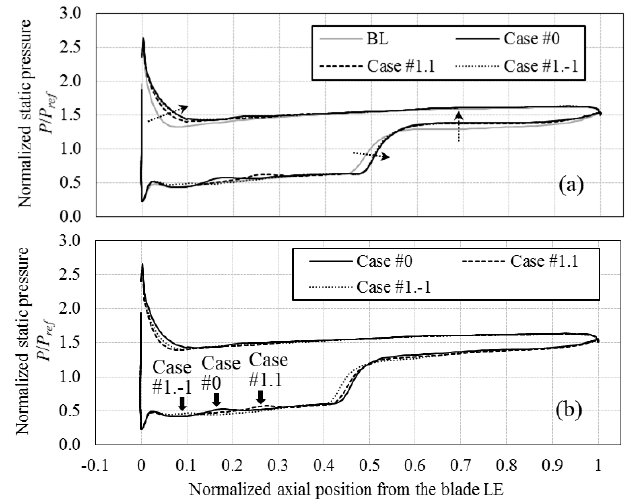
Figure 12. Normalized static pressure distribution at 0.98 span showing a decrease in the blade tip loading with the RC. ( a ) OP-A and ( b ) OP-B.